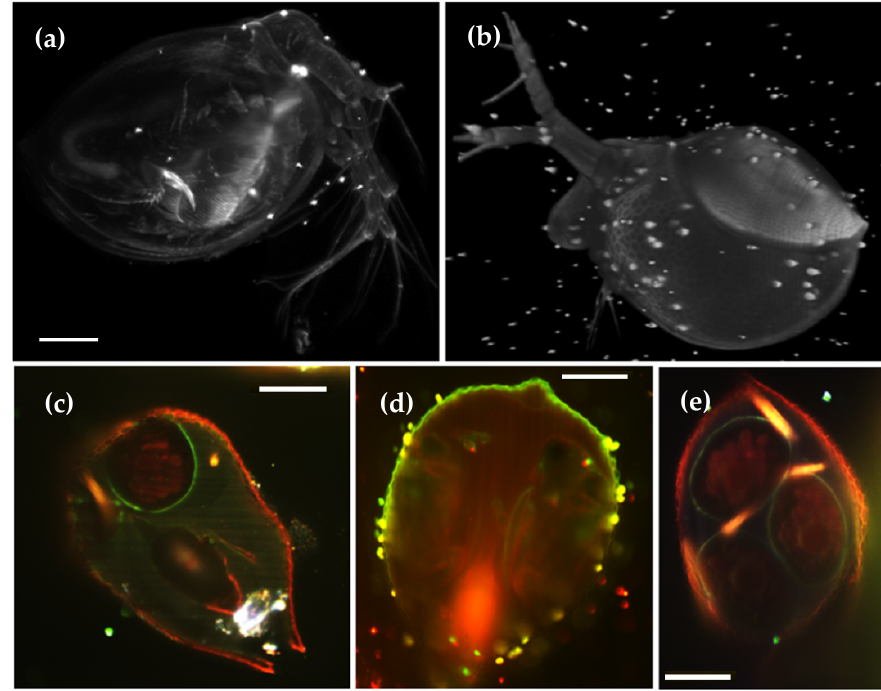
Figure 6. Auto-fluorescence from Daphnia pulex ( a ) maximum intensity projection obtained with 16× detection objective and 488 nm laser excitation. The inner organs are visible. A 3D volume rendering as well as the inner organs are shown in Video S6. ( b ) Volume reconstruction of a water flea that presents resting eggs in the dorsal part of its cuticle. ( c ) Cross-section of a daphnia with internal eggs. Auto-fluorescence excited with 488 nm appears in red and with 568 nm in green. ( d ) Cross-section of a daphnia with juveniles hidden inside its mother. ( e ) Cross-section of a daphnia with internal eggs, colonized by parasites (bright orange signal). Scale bar: 100 µm.